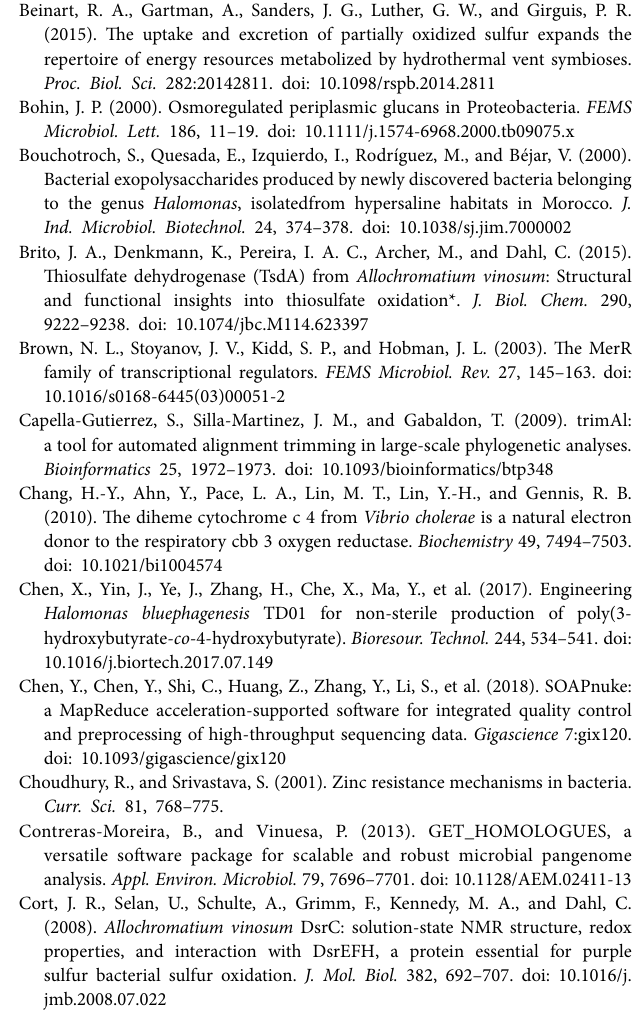
Supplementary Table S2 | Summary of genomic information of 228 Halomonas genomes. Supplementary Table S3 | Summary of genomic information of 14 Halomonas genomes. Supplementary Table S4 | Genes related to metal ion metabolism in Halomonas titanicae SOB56 (CP059082). Supplementary Figure S1 | KEGG annotation results for 15 Halomonas genomes. Categories of pathways are presented at left side of heatmap by different colors. Color of each cell refers to completeness of enzymes involved in each pathway.